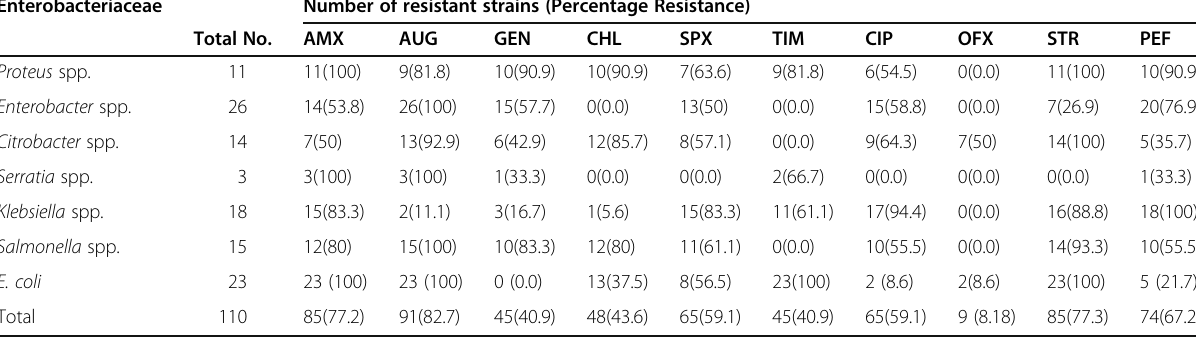
Table 2 Resistance of enteric bacteria to antibiotics Enterobacteriaceae Number of resistant strains (Percentage Resistance) Total No. AMX AUG GEN CHL SPX TIM CIP STR PEF Proteus spp.